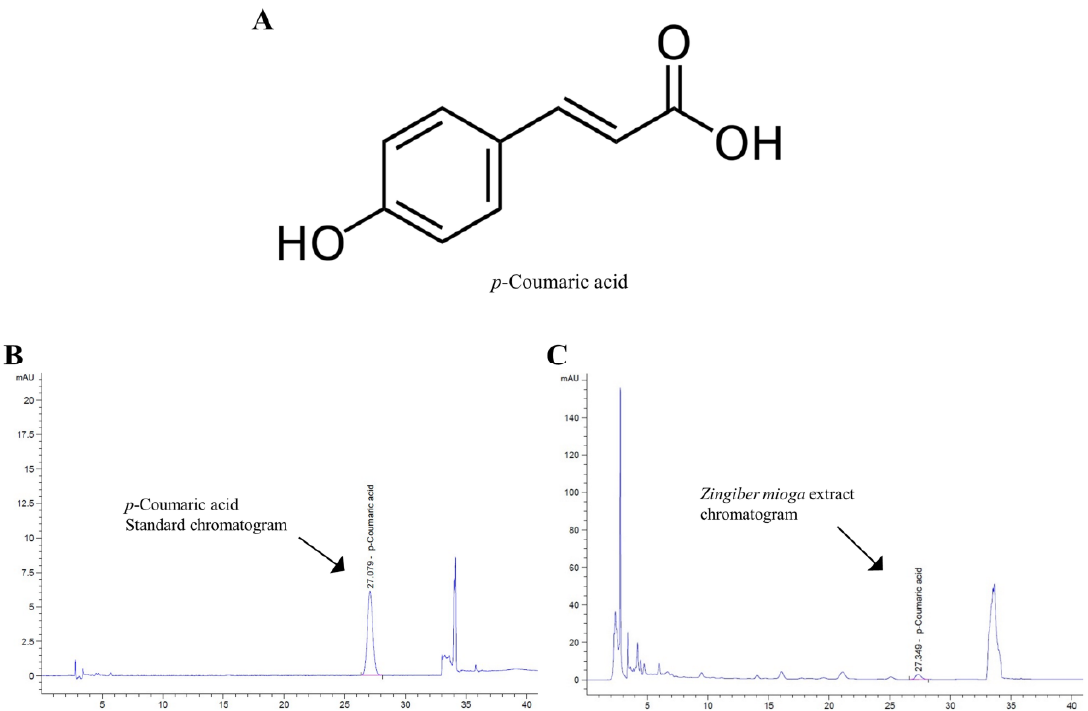
Figure 1. HPLC chromatograms of p-coumaric acid in the ZM extract at 310 nm. ( A ) p-coumaric acid structure, ( B ) p-coumaric acid standard chromatogram, ( C ) ZM extract chromatogram. The peaks appeared with retention times of approximately 27.079 min. Table 2. Effects of FSH-ZM on body weight and organ weights of HRM-2 mice with or without UVB-irradiation. UVB